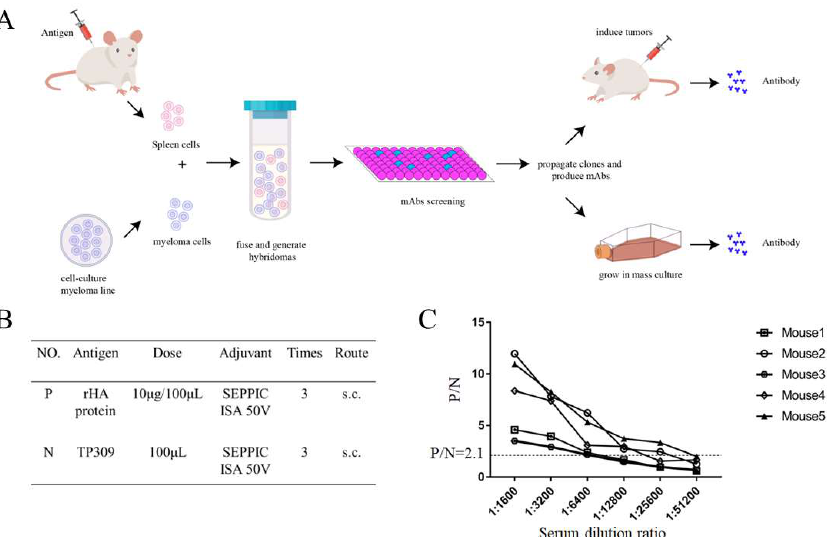
Figure 1. H9N2 HA immunization and process of generate mAbs. ( A ) Schedule of generate mAbs by hybridoma technology. BALB/c mice were immunized with HA antigen and generate mAbs. The spleen cells were fused with the myeloma cells and were screened, and finally hybridoma cells were propagated to produce mAbs. ( B ) Details of immunizing dose, adjuvant, frequency and routes. S.C represents subcutaneous injection. ( C ) HA-specific antibody of serum detected by indirect ELISA. N represents OD 450nm of mice sera immunized with TP309. P stands for OD 450nm of mice sera immunized with recombinant HA protein; P/N ≥ 2.1 is considered as positive. All the data are repeated three times and the average values are calculated.